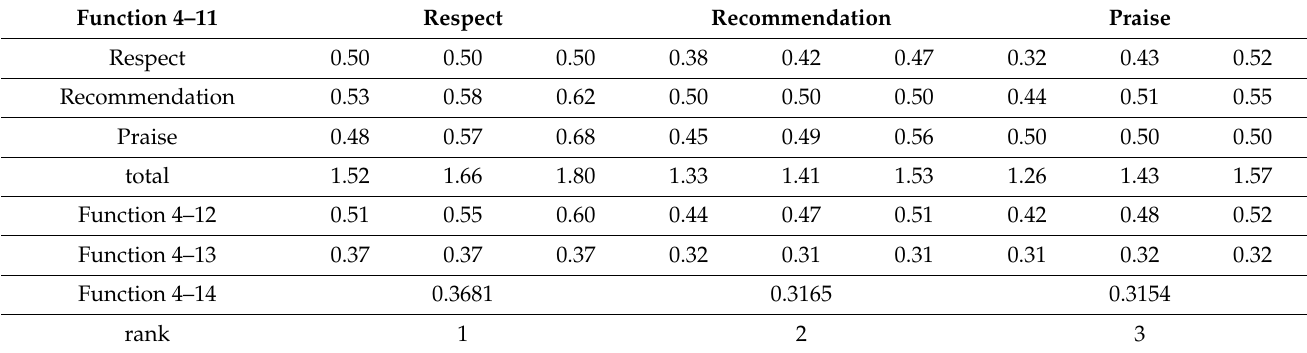
Table A16. Hotels’ weights of attributes of the social